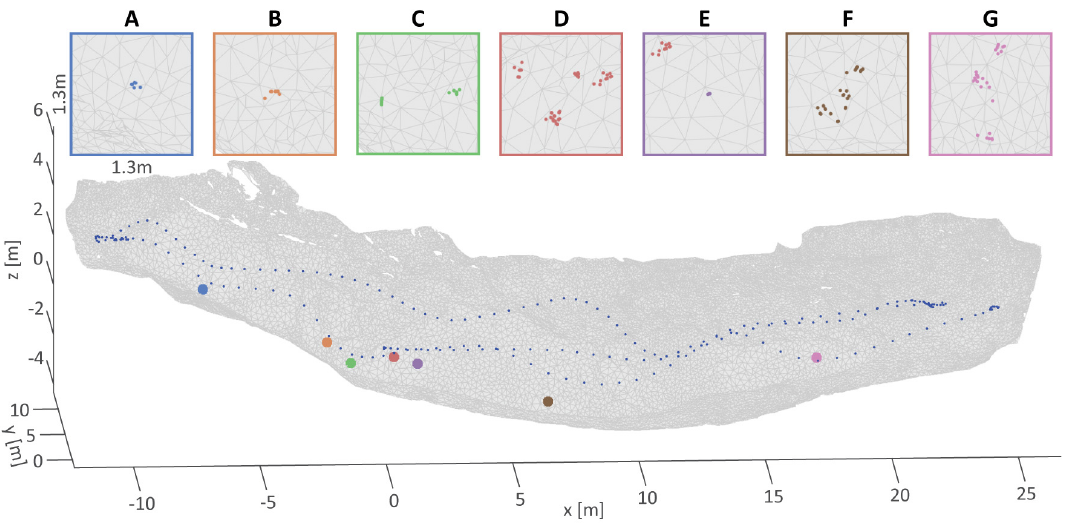
Figure 22. 3D reconstruction with the distribution of laser observations per segment for FPA area. Table 3. Distribution of laser observations per segment for FPA